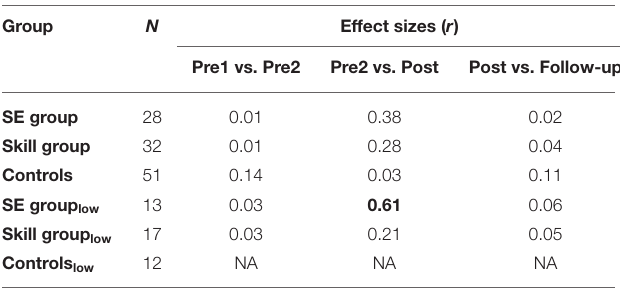
TABLE 3 | Effect sizes for changes in self-efficacy